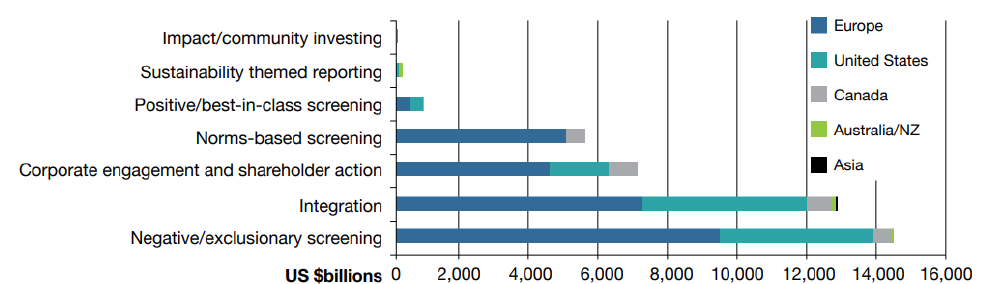
Figure A8. SRI assets by strategy and region